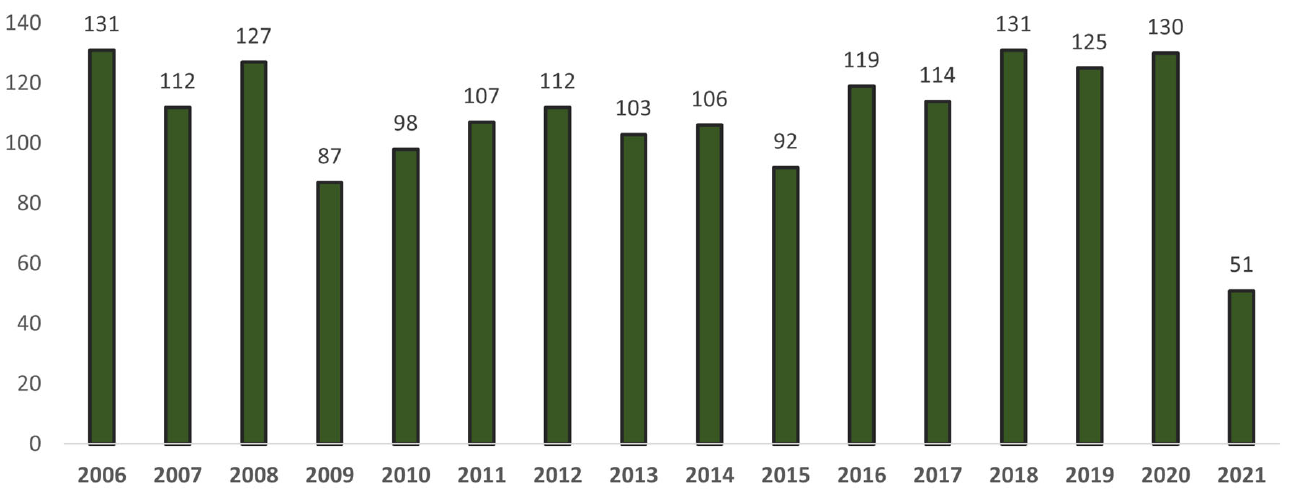
Figure 2. Result of a quick search of articles devoted to THA vs. year. Librarysearch.library.utoronto.ca. (accessed on 18 August 2022).